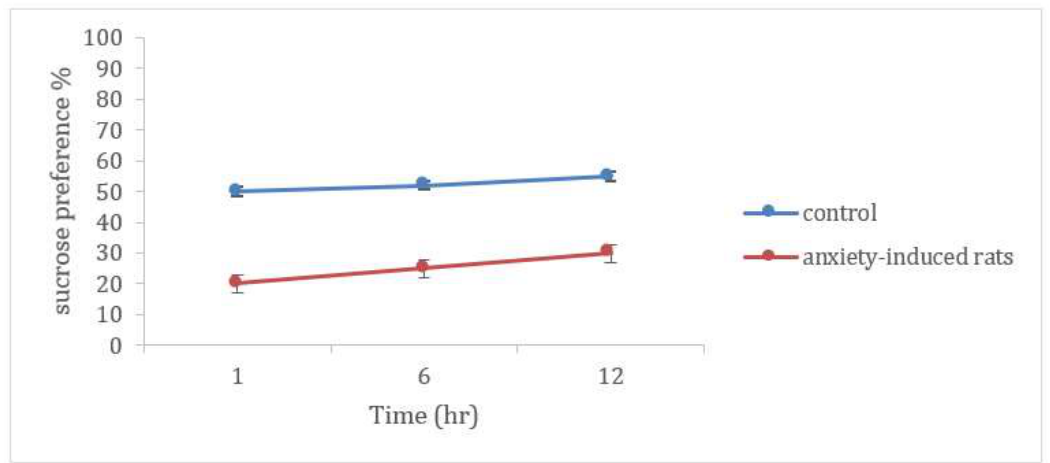
Figure 7. Sucrose preference test in control and anxiety-induced rats .